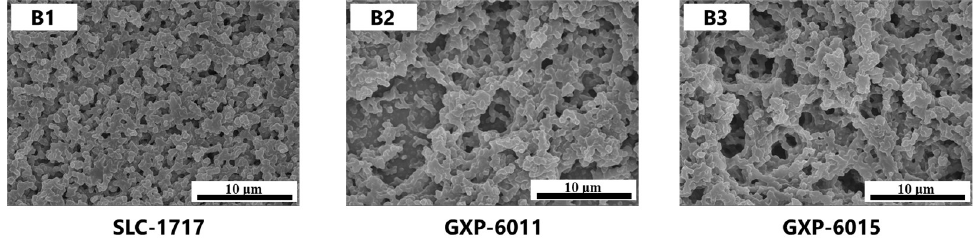
Figure 3. Microphotography of the morphology of PDLC films with different liquid crystals, B1 (SLC-1717), B2 (GXP-6011), and B3 (GXP-6015). (SLC-1717), B2 (GXP-6011), and B3